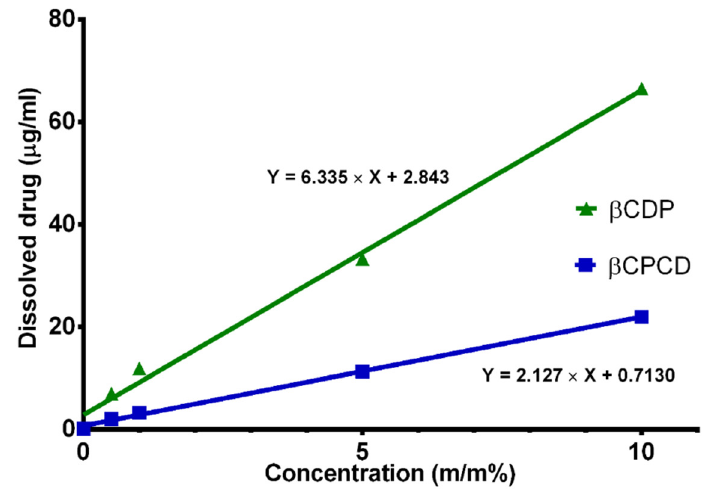
Figure 1. Phase-solubility curve presents the solubility of curcumin (ug/mL) in water versus the m / m % concentration of the cyclodextrin polymers, β CDP (green curve) and β CPCD (blue curve). Data are presented as means ± SD; n = 3.